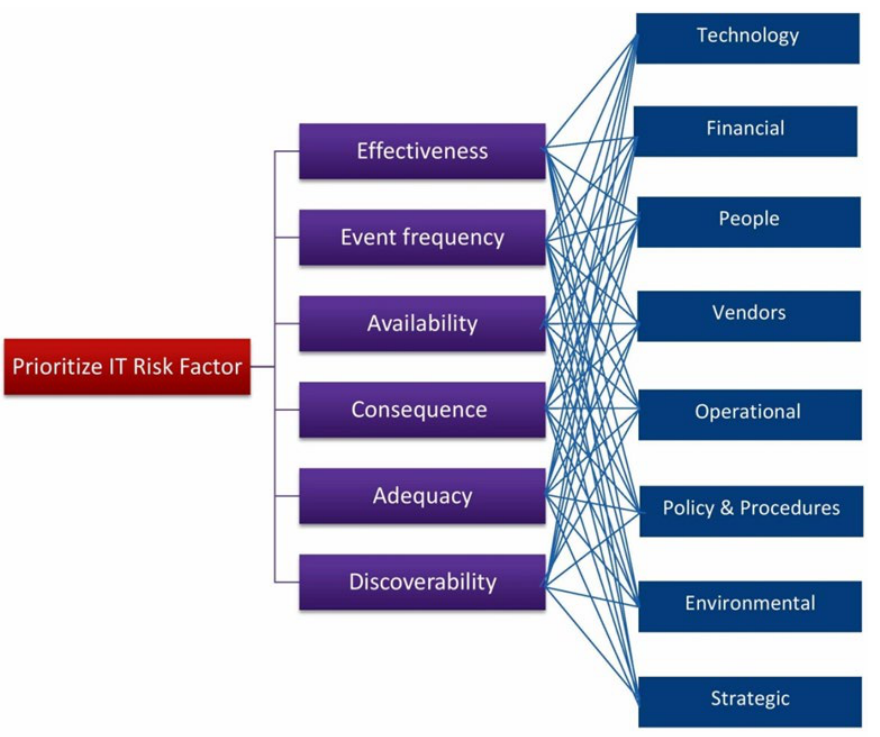
Figure 3. Hierarchical structure for the evaluation.